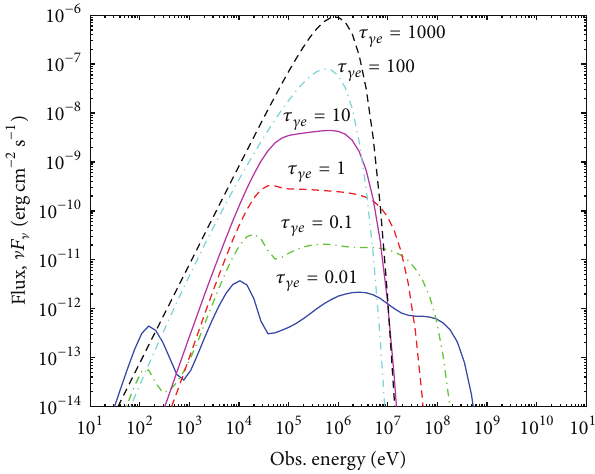
Figure 17: Time averaged broadband spectra expected following kinetic energy dissipation at various optical depths. For low optical depth, the two low energy bumps are due to synchrotron emission and the original thermal component, and the high energy bumps are due to inverse Compton phenomenon. At high optical depth, 𝜏 ≥ 100, a Wien peak is formed at ∼ 10 keV and is blue-shifted to the MeV range by the bulk Lorentz factor ≃ 100 expected in GRBs. In the intermediate regime, 0 . 1 < 𝜏 < 100, a flat energy spectrum above the thermal peak is obtained by multiple Compton scattering. Figure is taken from Pe’er et al.